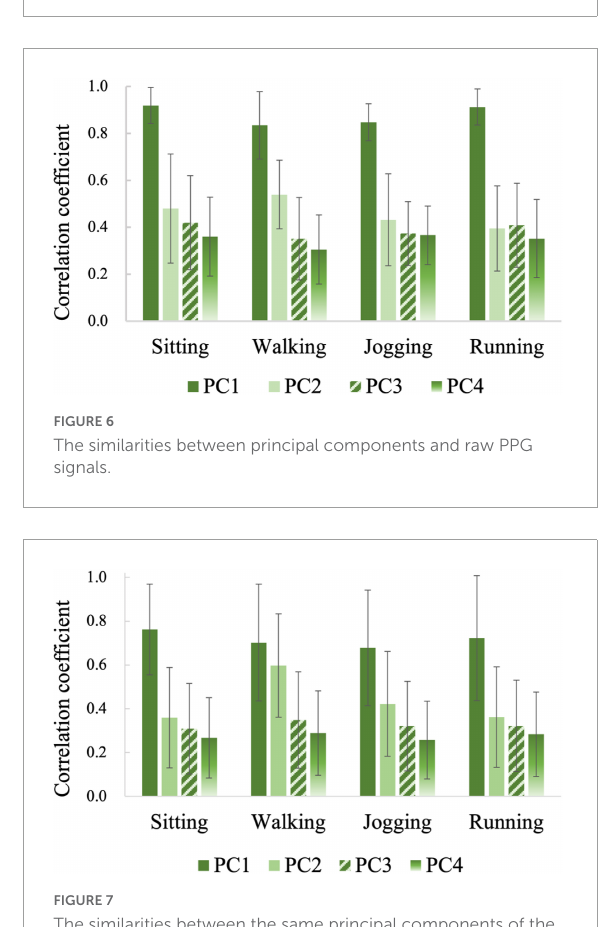
to 0.68, while those of PC 2, PC 3, and PC 4 are mostly